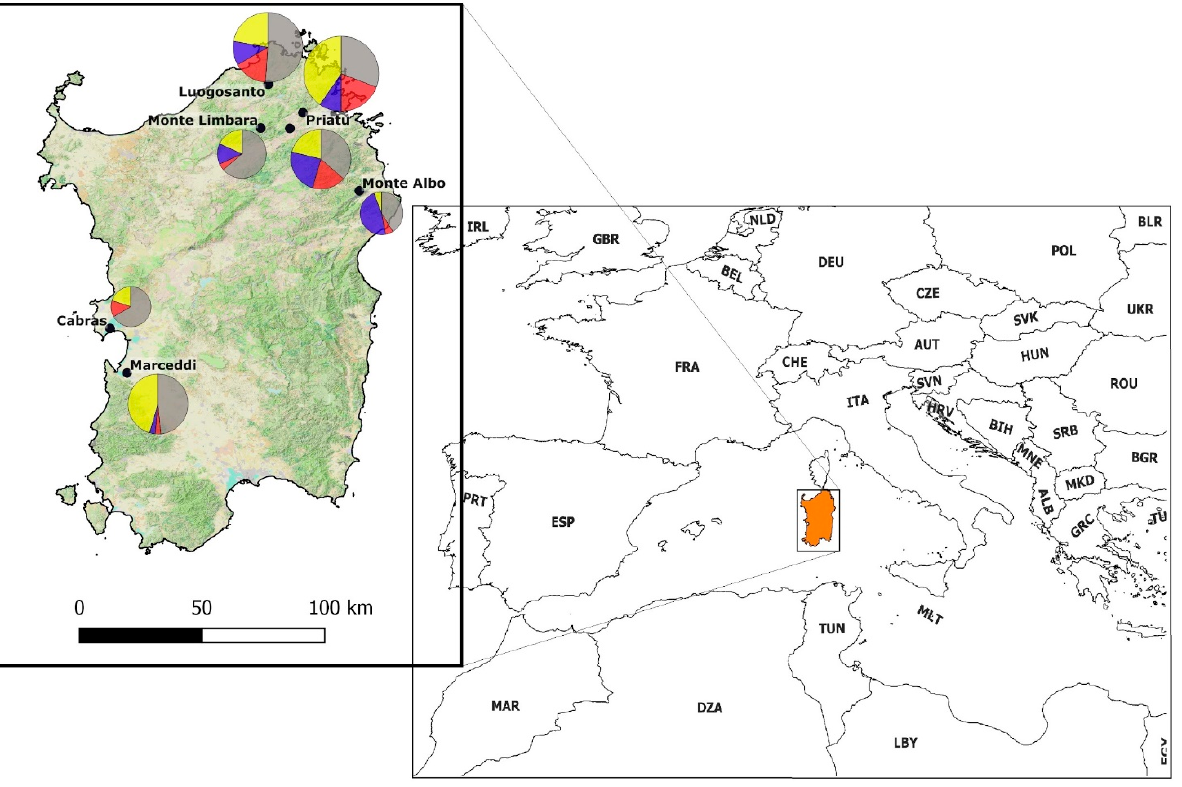
Figure 1. Study area location in the Mediterranean basin. Sampling localities (black dots) are Cabras (3 m asl), Luogosanto (216 m asl), Marceddì (3 m asl), Monte Albo (780 m asl), Monte Limbara (1309 m asl), Priatu (308 m slm), Telti (368 m asl). Pie diagrams show the proportion for each site of uninfected birds (grey) and birds infected by Haemoproteus (yellow), Leucocytozoon (blue) and Plasmodium (red).